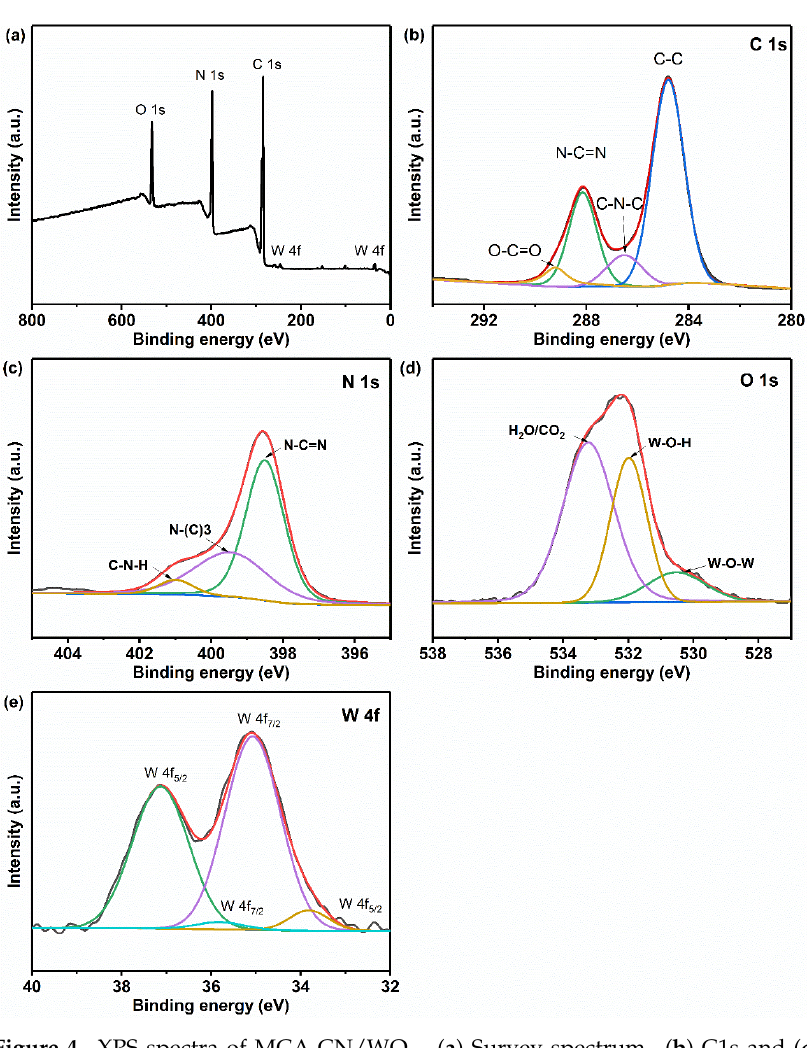
Table 1. Surface area, pore volume and pore size of ME-CN, MCA-CN and MCA-CN/WO 3 . Samples Figure 4. XPS spectra of MCA-CN/WO 3 . ( a ) Survey spectrum. ( b ) C1s and ( c ) N1s spectra of MCA-CN/WO 3 . ( d ) O1s and ( e ) W 4f spectra of MCA-CN/WO 3 .